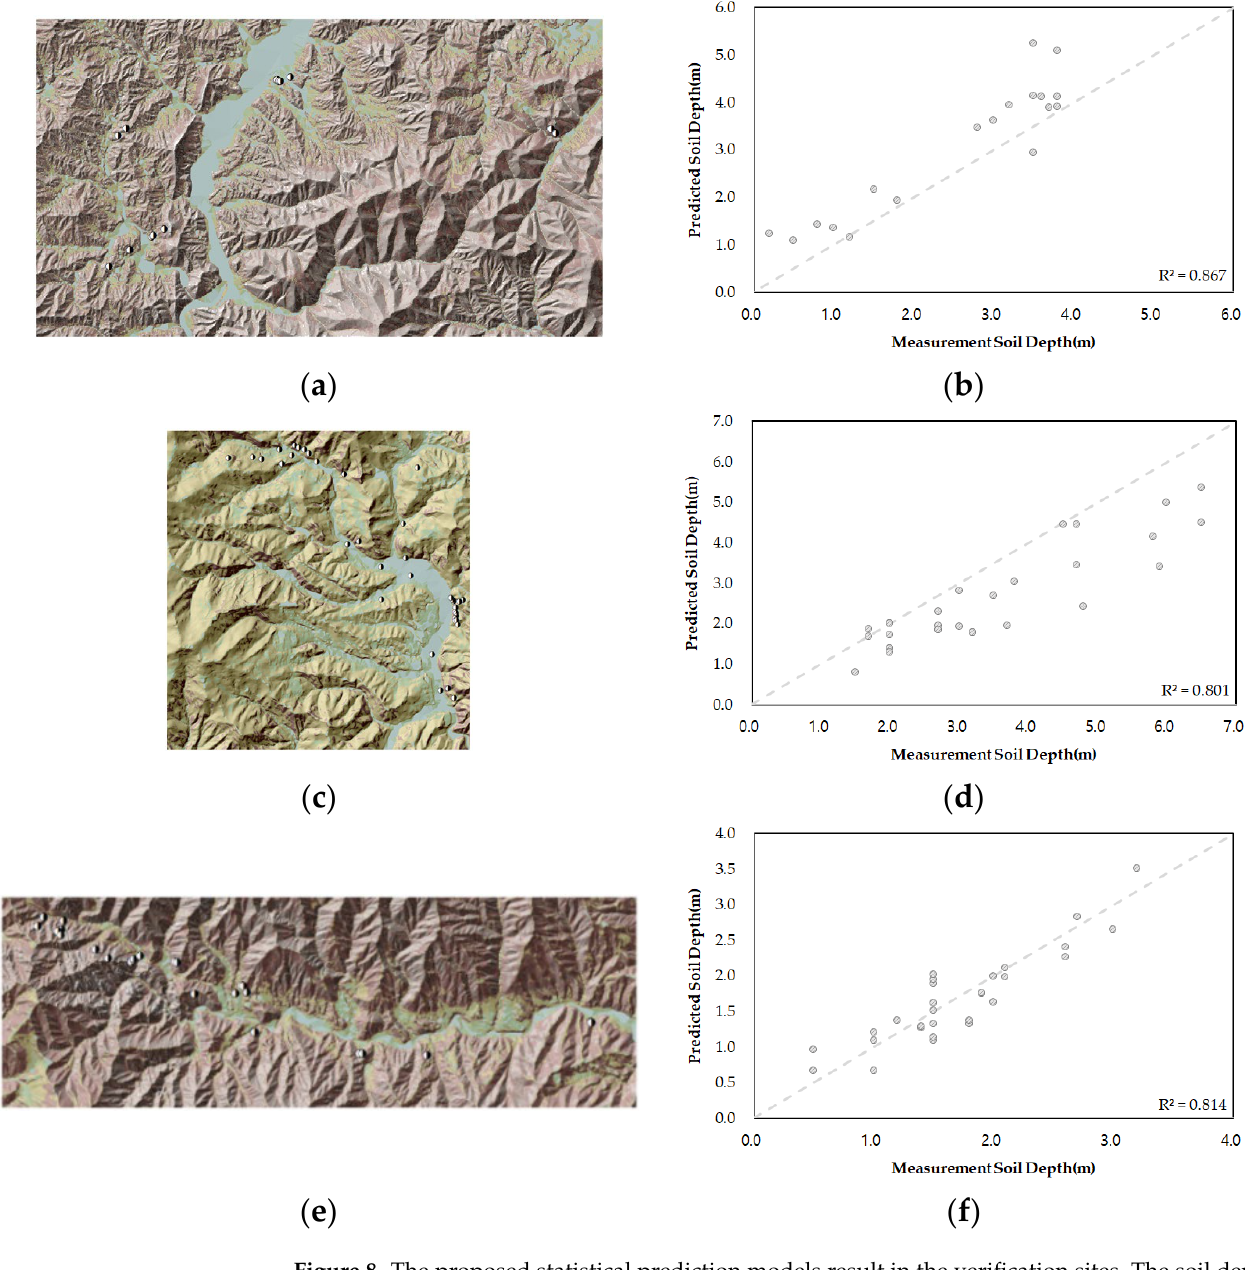
= 0.867), ( d ) Met- 2 𝑅𝑅